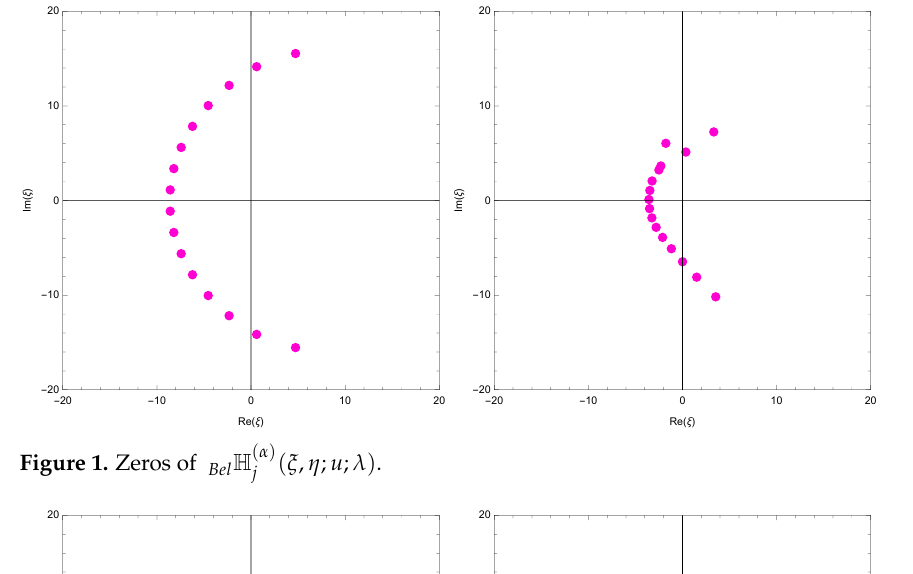
Figure 1. Zeros of Bel H